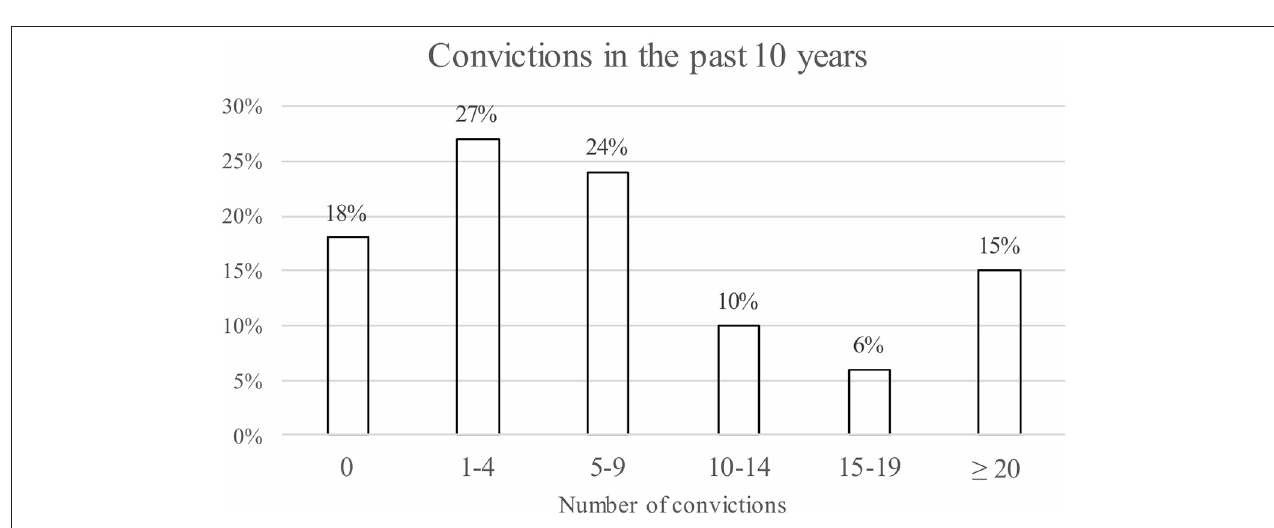
FIGURE 3 | An overview of the number of convictions of the ForFACT patients in the past 10 years ( n =